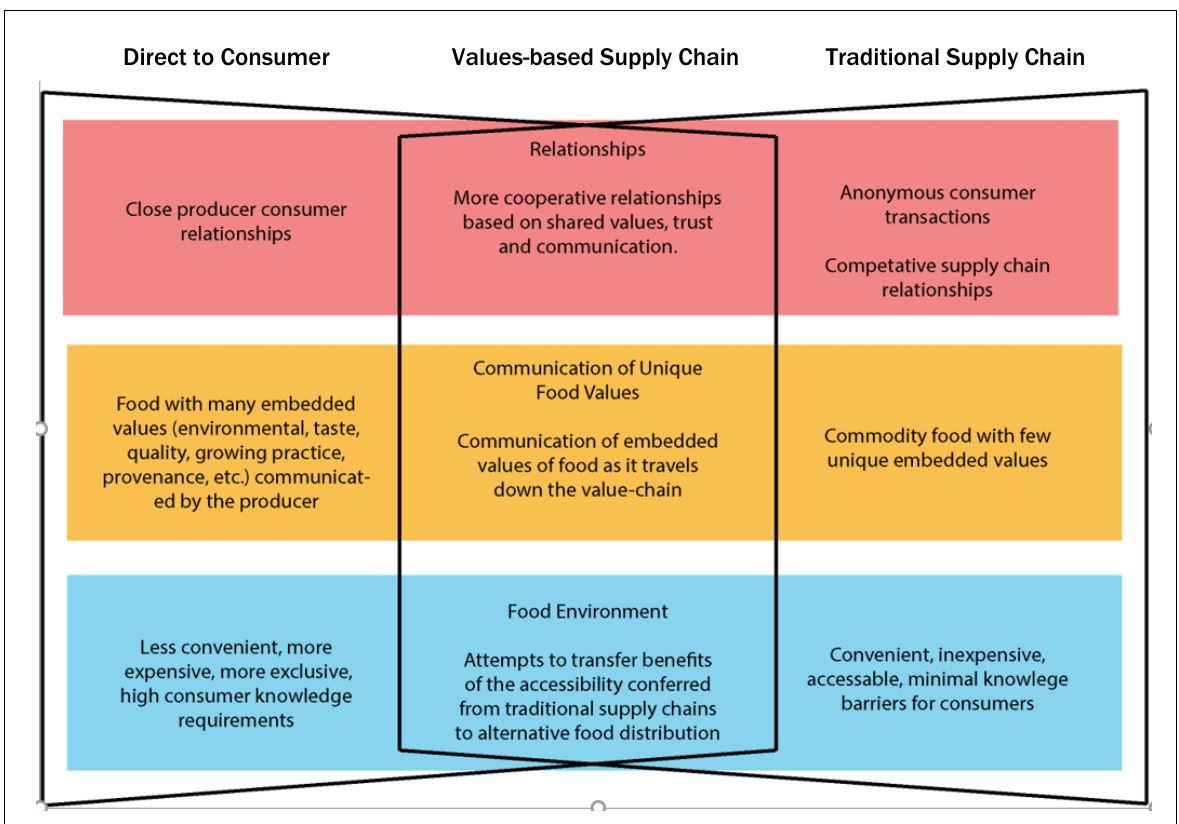
Figure 2. Comparison of Direct-to-Consumer, Values-Based, and Traditional Food Supply Chains